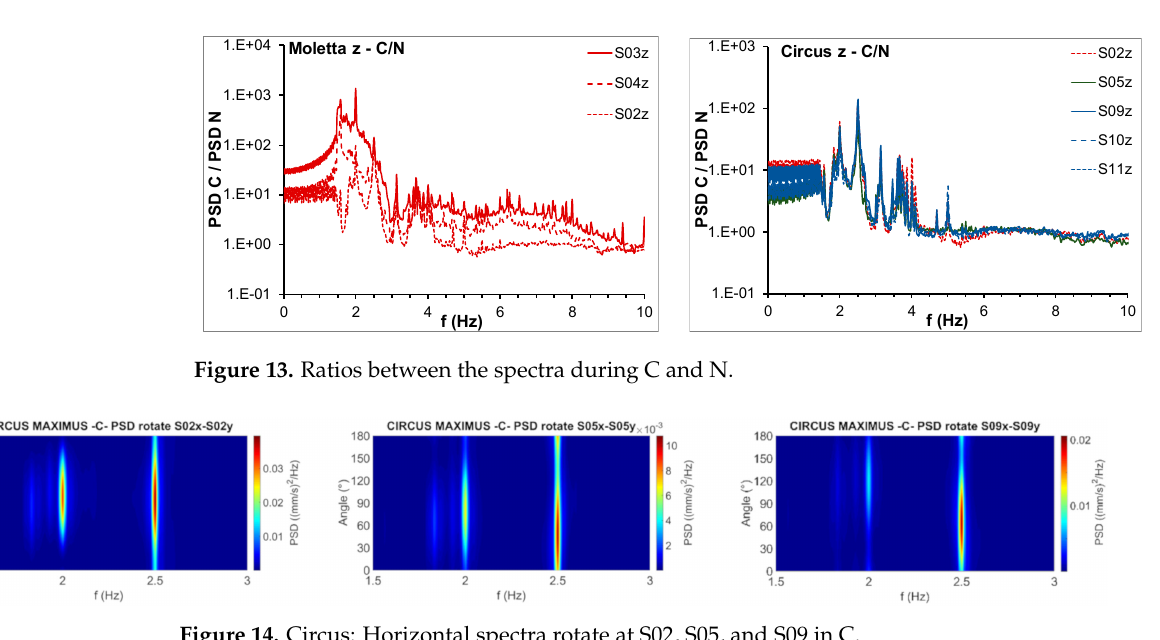
Figure 14. Circus: Horizontal spectra rotate at S02, S05, and S09 in C. The CDSs plotted in Figure 15 often show significant values of the phase factor and the coherence function between the records at different locations, validating the hypothe- sis about presence of buried structures.